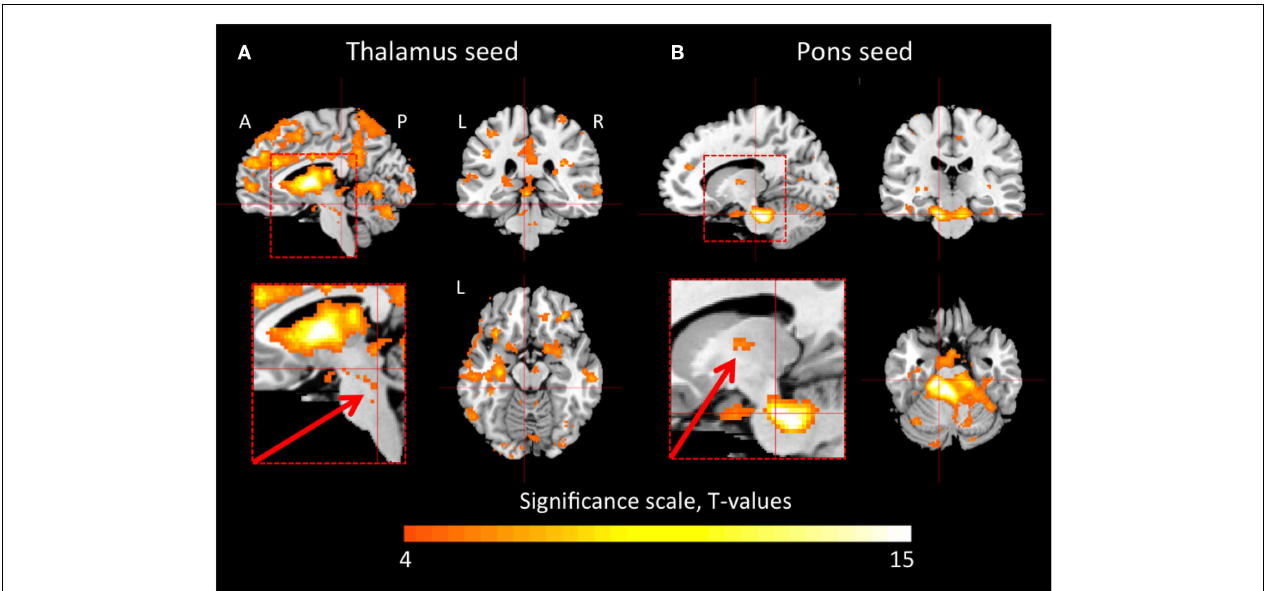
corresponds to p < 0.001.The inserts show magnifications of the brain stem and thalamus.The arrows point to connections between the brain stem and the thalamus that were reduced in the patient during hypersomnia. A, anterior; P, posterior; L, left; R, right.